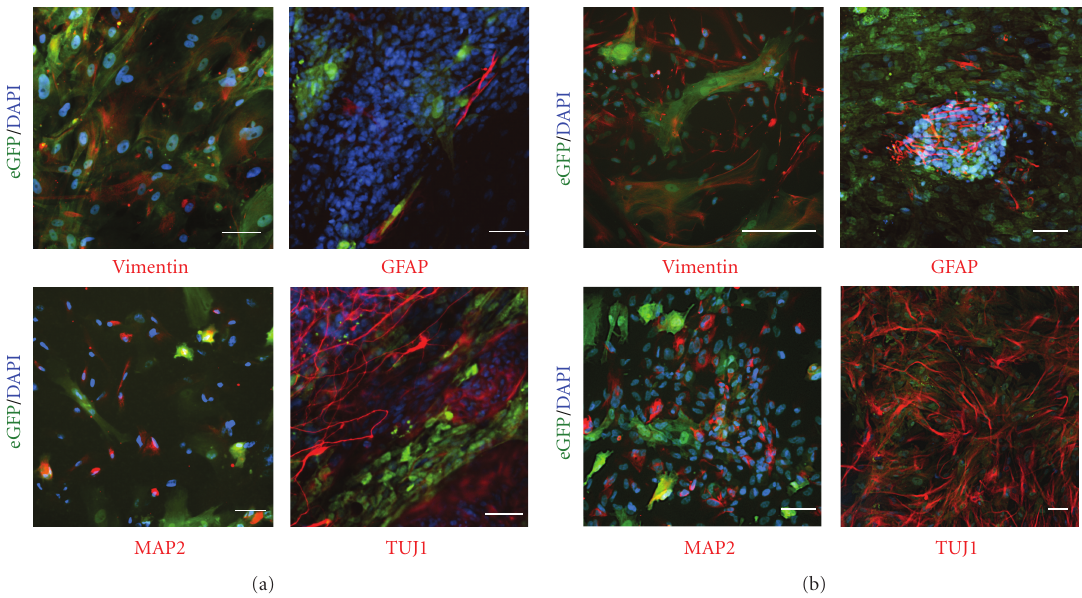
Figure 4: Expression of neural lineage-related cytoskeletal proteins in cjes001 CESCs (a), Riv9 HIPSCs (b). Immunocytochemistry using antibodies specific for neural markers are shown in red. Green fluorescence indicates eGFP expression in pCAG-transfected di ff erentiated derivatives. Scale bars, 50 μ